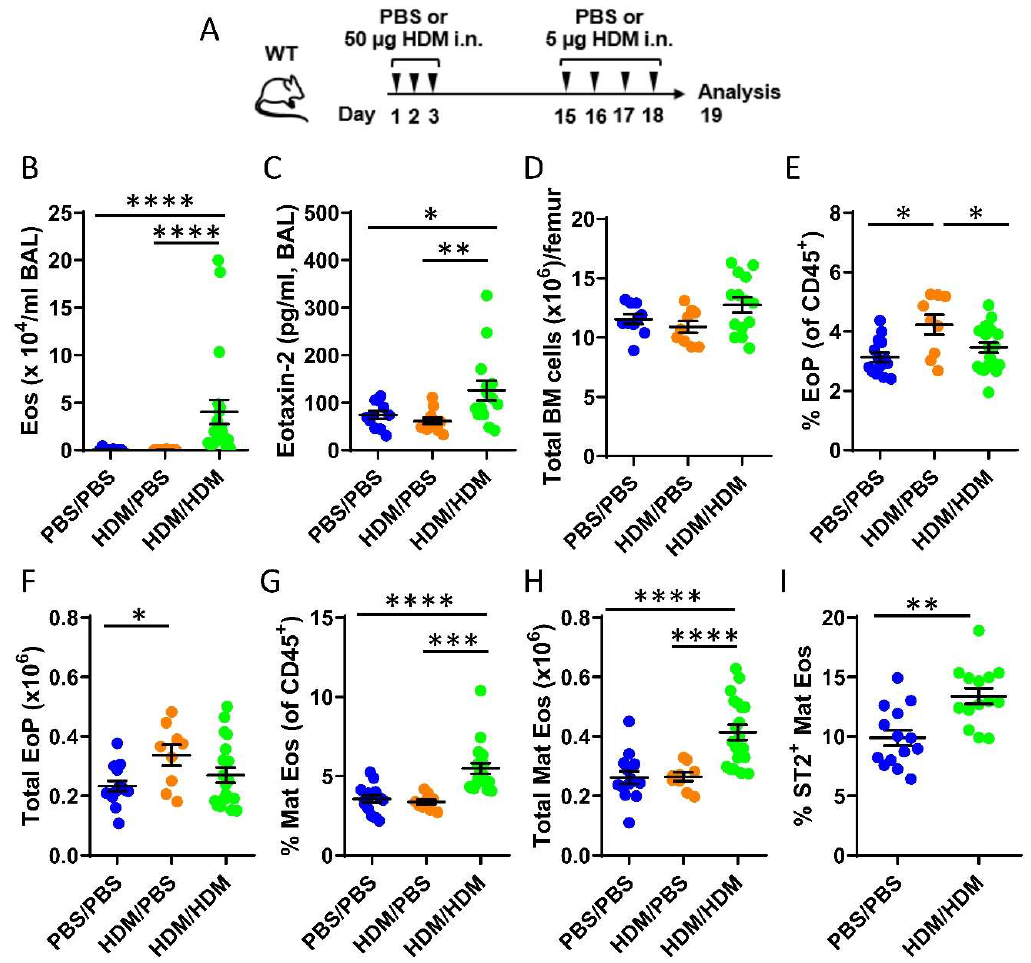
Figure 1. E ff ects of airway exposures to house dust mite (HDM) on eosinophil development and ST2 expression in the bone marrow. ( A ) Allergen inflammation model where wild type (WT) mice received intranasal (i.n.) doses of HDM extract or phosphate bu ff er saline (PBS) vehicle on days 1–3 and 15–18 and were sacrificed 24 h after the final exposure. ( B ) Total number of eosinophils in bronchoalveolar lavage (BAL) analyzed by di ff erential cell count. ( C ) Concentration of CCL24 / Eotaxin-2 in BAL measured by ELISA. ( D ) Total number of bone marrow cells per femur. ( E ) Number of eosinophil progenitors among all CD45 + bone marrow leukocytes. ( F ) Total number of eosinophil progenitors per femur. ( G ) Number of mature eosinophils among CD45 + bone marrow leukocytes. ( H ) Total number of mature eosinophils per femur. ( I ) Numbers of ST2 + Mat Eos among all CD45 + bone marrow leukocytes. Data are representative of 2–4 independent experiments (n = 9–20 / group) and displayed as the mean ± SEM. Mann–Whitney U test. * p < 0.05, ** p < 0.01, *** p < 0.001 and **** p < 0.0001. PBS / PBS = controls. HDM / PBS = HDM-sensitized. HDM / HDM = HDM-sensitized and challenged. BM = bone marrow. EoP = eosinophil progenitors. Mat Eos = mature eosinophils. ST2 = IL-33 receptor.